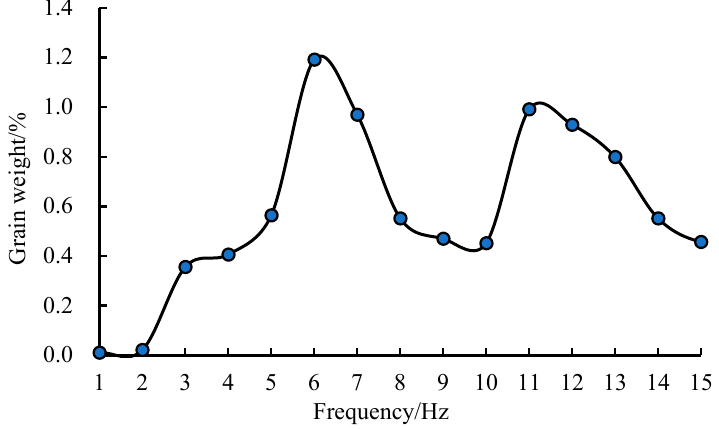
Figure 8. Vibration seed falling of rape plants under different frequencies.